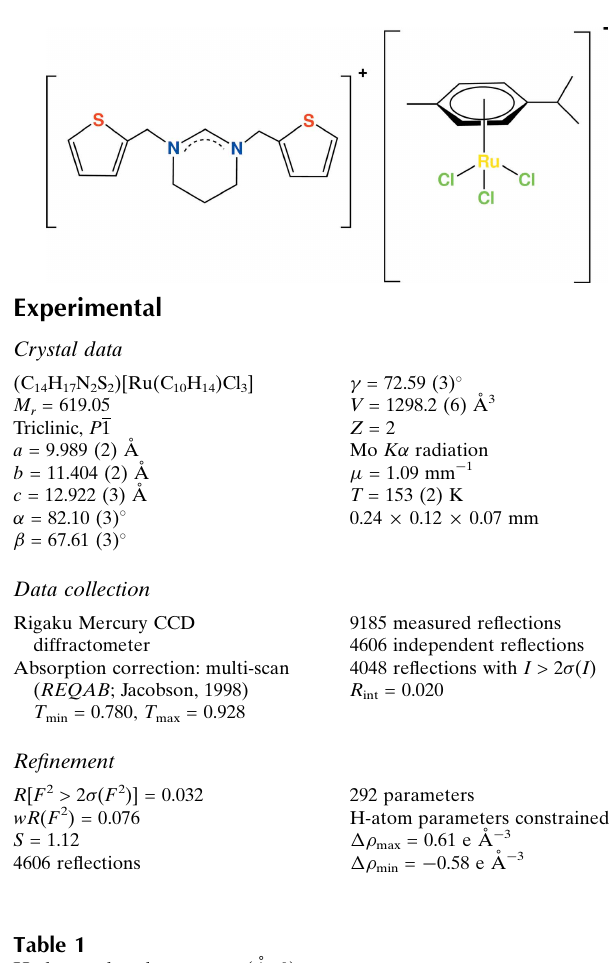
Hydrogen-bond geometry (A˚ , (cid:2)